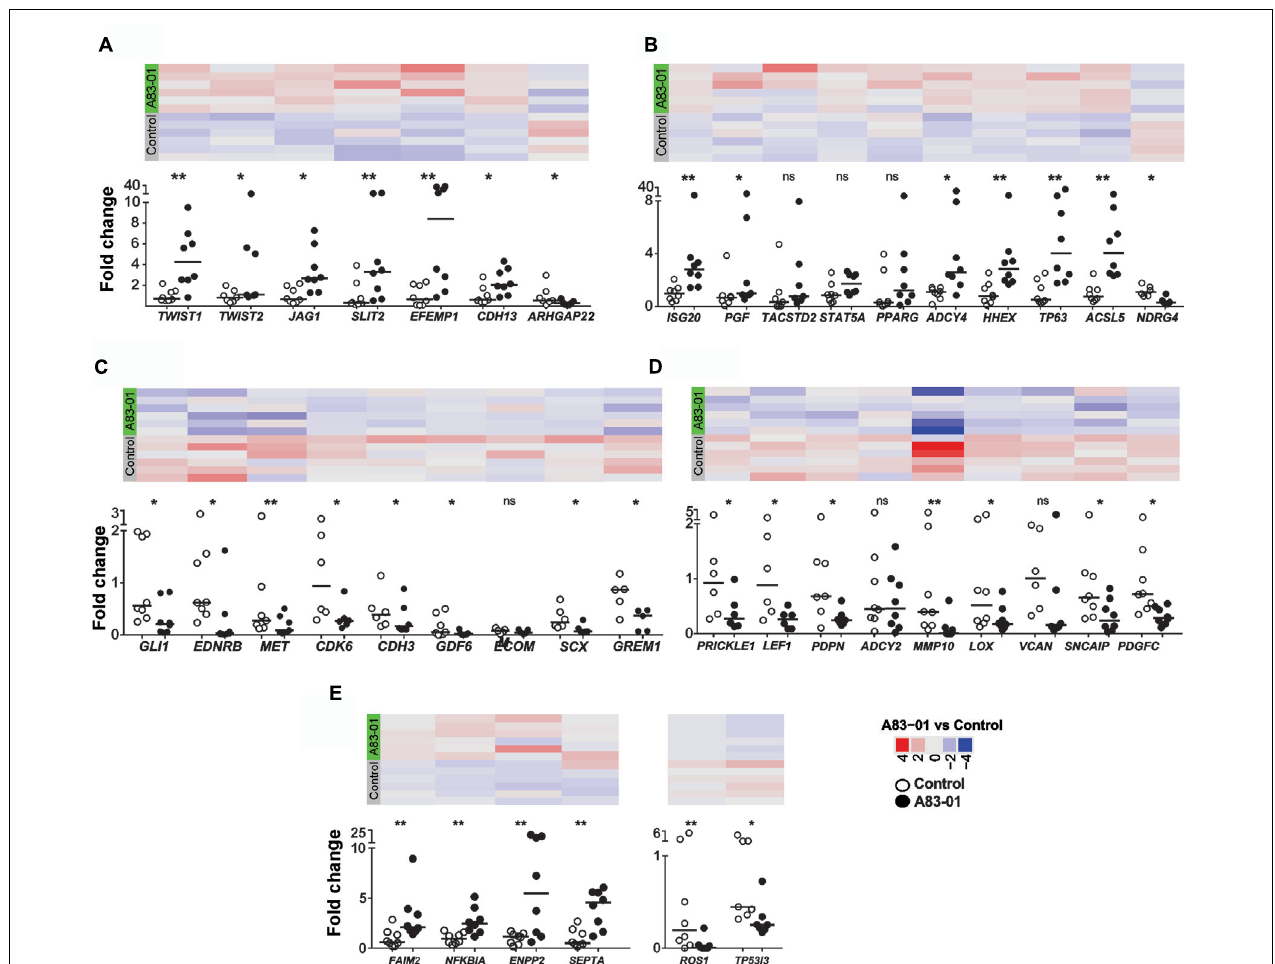
FIGURE 4 | Differentially expressed genes (DEGs) confirmed by Fluidigm qPCR. (A) MSC potency, (B) proliferation, (C) anti-proliferation, (D) fibroblast and (E) apoptosis-related genes were validated in control and A83-01 treated P6 eMSCs. Data points (black circles, A83-01-treated, white circles, control) and medians are shown. Panels above each graph shows the heat map of the corresponding genes in RNA seq ( ∗ p < 0.03, ∗∗ p < 0.002, n =